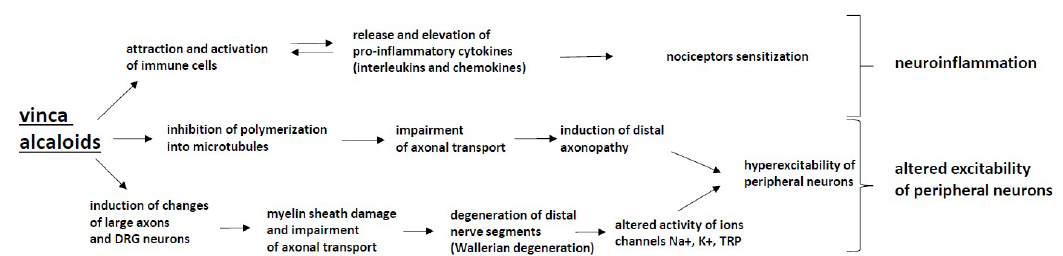
Figure 5. The mechanisms of CIPN induced by vinca alkaloids: Vinca alkaloids cause changes to large axons and DRG neurons, which leads to Wallerian degeneration, the altered activity of ion channels and the hyperexcitability of peripheral neurons. Moreover, the inhibition of polymerization into microtubules inhibits axonal transport, which leads to distal axonopathy. These processes alter the excitability of peripheral neurons, whereas the attraction and activation of immune cells by vinca alkaloids causes the release and elevation of pro-inflammatory cytokines (interleukins and chemokines), which results in neuroinflammation.